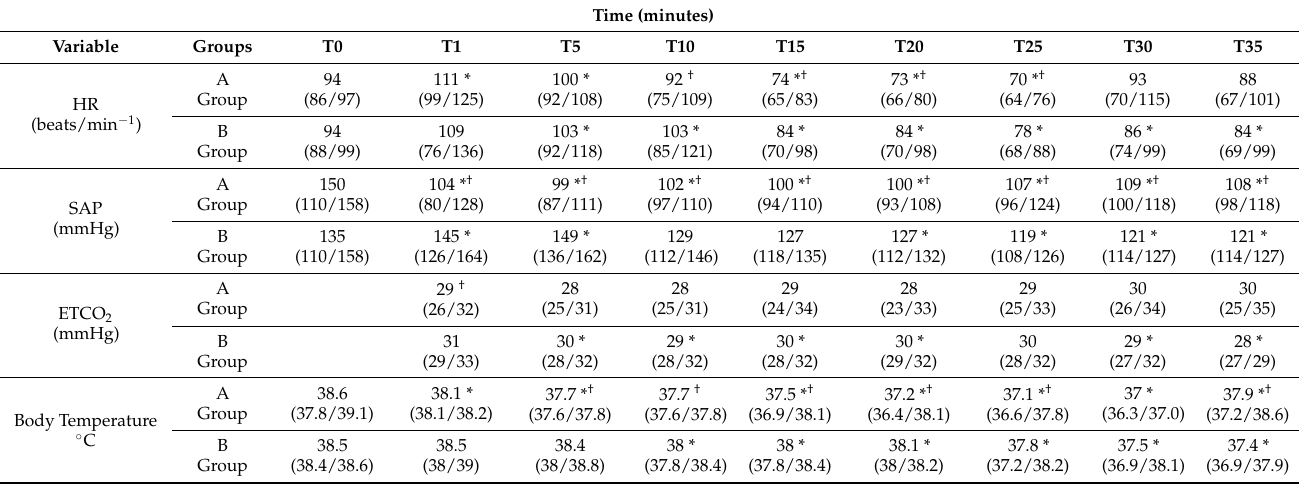
Table 3. Physiological parameters.